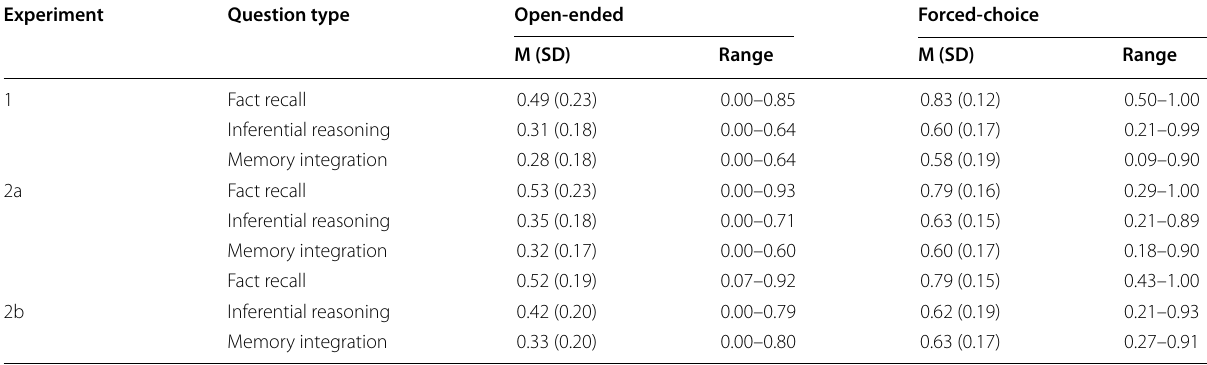
Table 1 Learning outcomes in terms of proportion of correct responses from each question type for Experiment 1, Experiment 2a, and Experiment